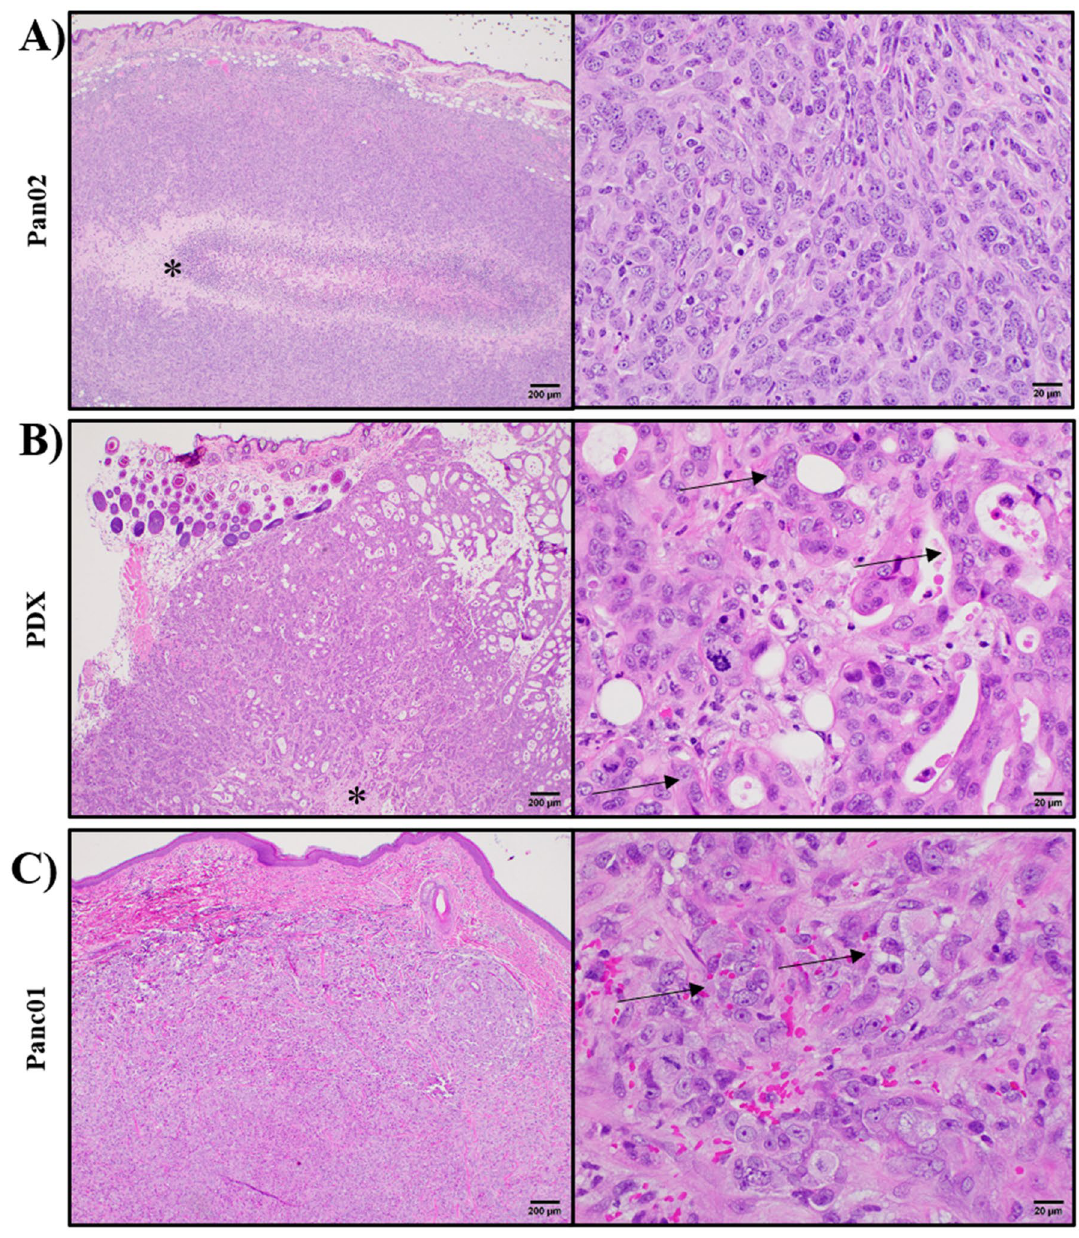
Figure 5. Histopathology comparison of pre-clinical pancreatic cancer animal models. mouse Pan02, human PDX, and human Panc01 were compared. ( A ) Subcutaneous tumors in the mouse Pan02 model are densely cellular often with central areas of necrosis (asterisk). Individual cells are spindle-shaped and arranged in vague, irregular streams. ( B ) Subcutaneous tumors in the PDX mice are also highly cellular and also exhibit foci of necrosis (asterisk). At higher magnification, these cells are more polygonal and are often arranged to form irregular tubular structures with lumens containing inflammatory cellsmurin and debris (arrows). ( C ) Subcutaneous tumors in the porcine Panc01 model are also densely cellular and variably exhibit foci of necrosis. Individual cells are more polygonal in shape and rarely attempt to recapitulate glandular structures studies have utilized human xenografts in immunocompromised mice or murine tumor injection into immu- nocompetent animals to generate tissue for ex vivo IRE studies. However, the small size of the mice is a restric- tion for tumor growth and limitation for any ultimate orthotopic studies. In general, cell line tumors from both animal models were highly similar. As expected, simply due to the immune system status of each animal, we did observe some minor differences in tumor histopathology. In the murine Pan02 and in the murine PDX subcu- taneous pancreatic adenocarcinoma models, nodular tumors develop at the site of injection (Fig. 5A,B, respec- tively). The Pan02 tumors are densely cellular with minimal fibrovascular stroma and often variably-sized foci of necrosis develop centrally within the tumor. Tumor cells are spindle in shape and tend to be arranged in vague, indistinct streams. Similar to most malignant tumor cells of any origin, they often exhibit marked pleomorphism